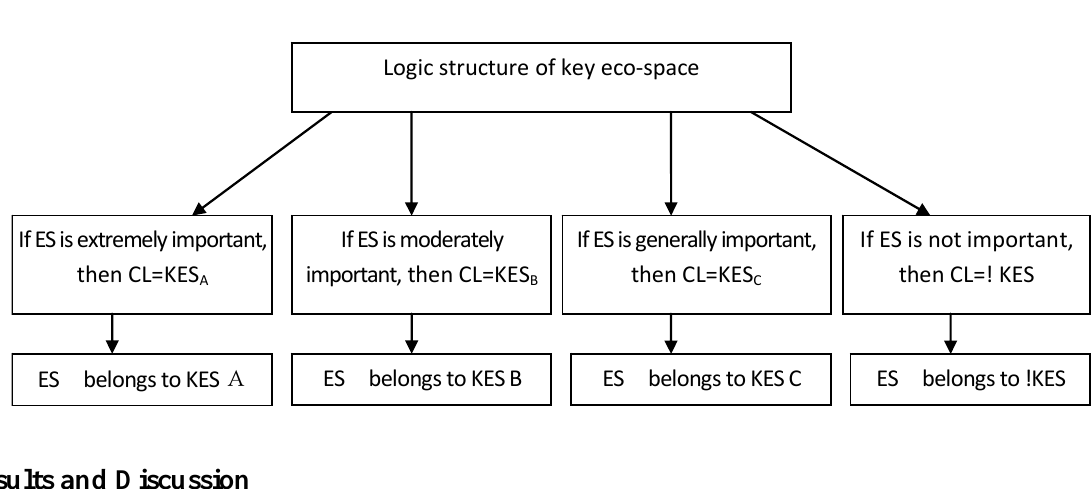
Figure 3. Model for identifying key eco-space.